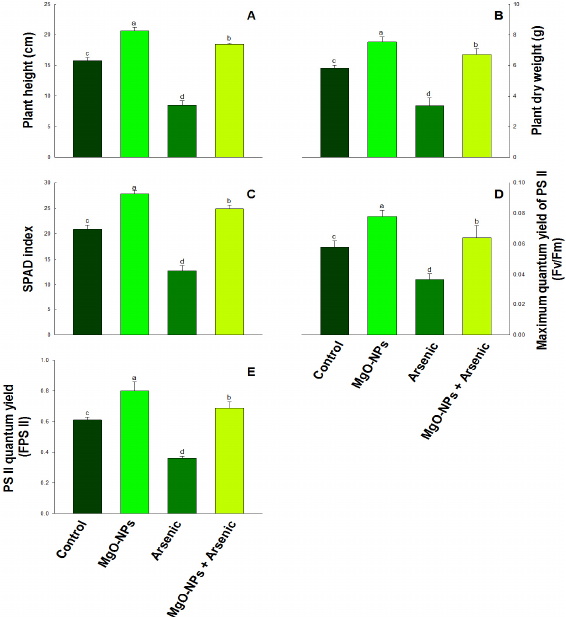
Figure 1. Plant height ( A ), plant dry weight ( B ), chlorophyll content measured as SPAD index ( C ), maximum efficiency of PSII photochemistry (F v /F m ) ( D ) and effective quantum yield of PSII photo- chemistry ( Φ PSII ) ( E ) of soybean plants before and after foliar spray with MgO-NPs in the pres- ence/absence (control) of As. Error bars represent standard deviation and different letters indicate significant differences at p < 0.05.